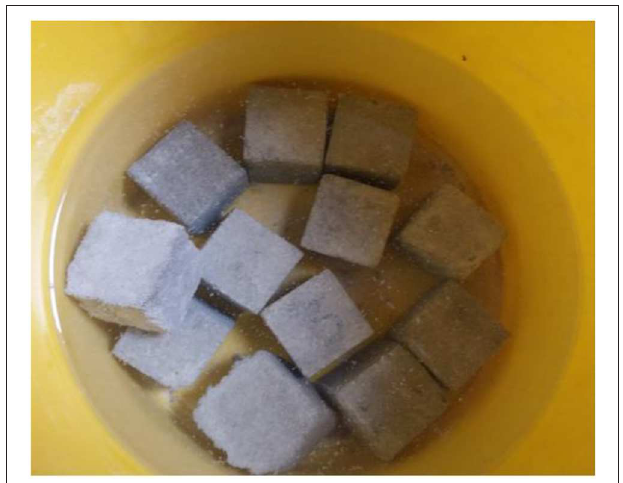
FIGURE 11 | Moist curing of mortar samples for TGA under controlled laboratory conditions.